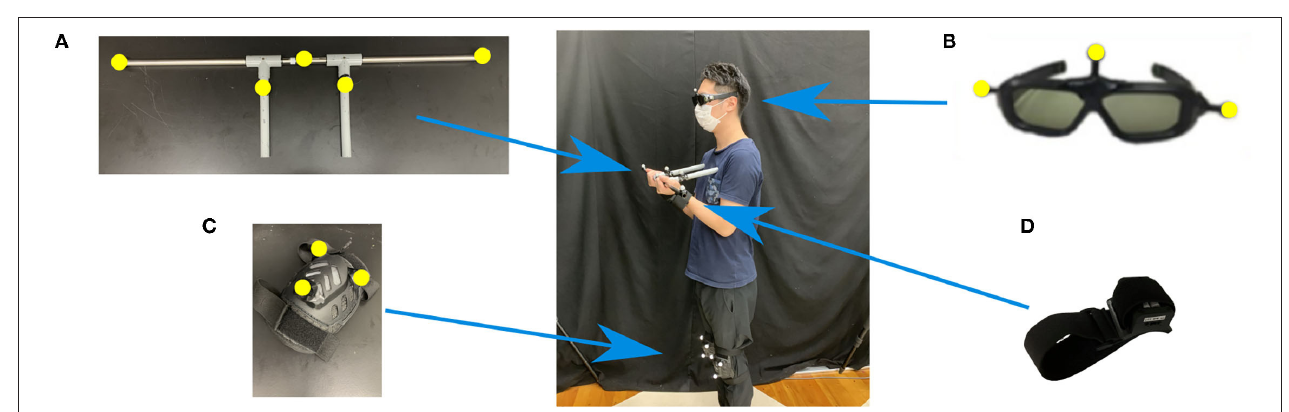
FIGURE 2 | Real environment for pre- and post-training tests.